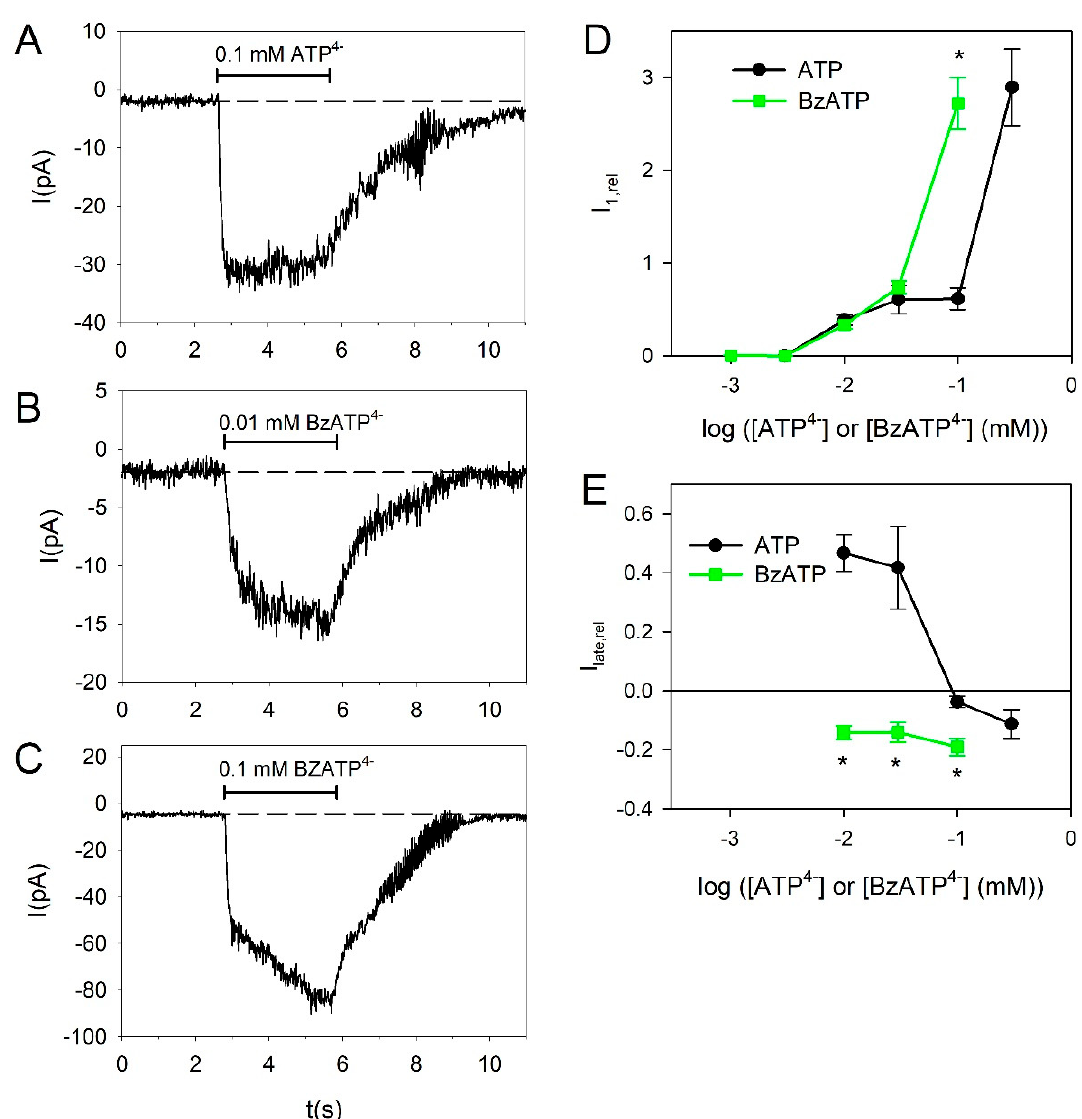
Figure 4. 2 ′ (3 ′ )- O -(4-Benzoylbenzoyl)adenosine 5 ′ -triphosphate (BzATP)-induced currents in BV-2 microglia cells. ( A – C ) Representative current traces induced by application of 0.1 mM ATP 4 − ( A ), 0.01 mM BzATP 4 − ( B ) and 0.1 mM BzATP 4 − ( C ). ( D , E ) Comparison of ATP 4 − - and BzATP 4 − -induced current amplitudes ( D ) and late currents I late,rel ( E ). Data for ATP 4 − are from Figure 1. BzATP: Means ± SEM of 14–35 cells. Significant di ff erences between BzATP 4 − and ATP 4 − are marked by